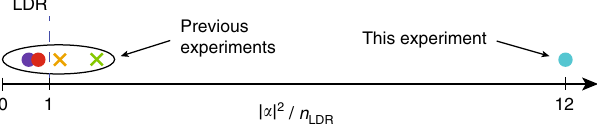
Fig. 1 Mesoscopic superposition states and the Lamb-Dicke regime (LDR). Mesoscopic superposition states of trapped atom motion have been created in a number of different experimental apparatuses. Here we plot the average phonon number | α | 2 from a selection of the largest superposition states created to date, each normalised to the phonon number associated with their LDR boundary n LDR = 1/(2 η 2 ) − 1/2. In the experiments denoted by “ x ” points, the applied force became more strongly position-dependent beyond the LDR, causing signi fi cant and unavoidable distortion of the displaced coherent states ( orange 32 , green 21 ). The circular points signify undistorted displaced states ( red 6 , blue (this experiment)) or squeezed states ( purple 8